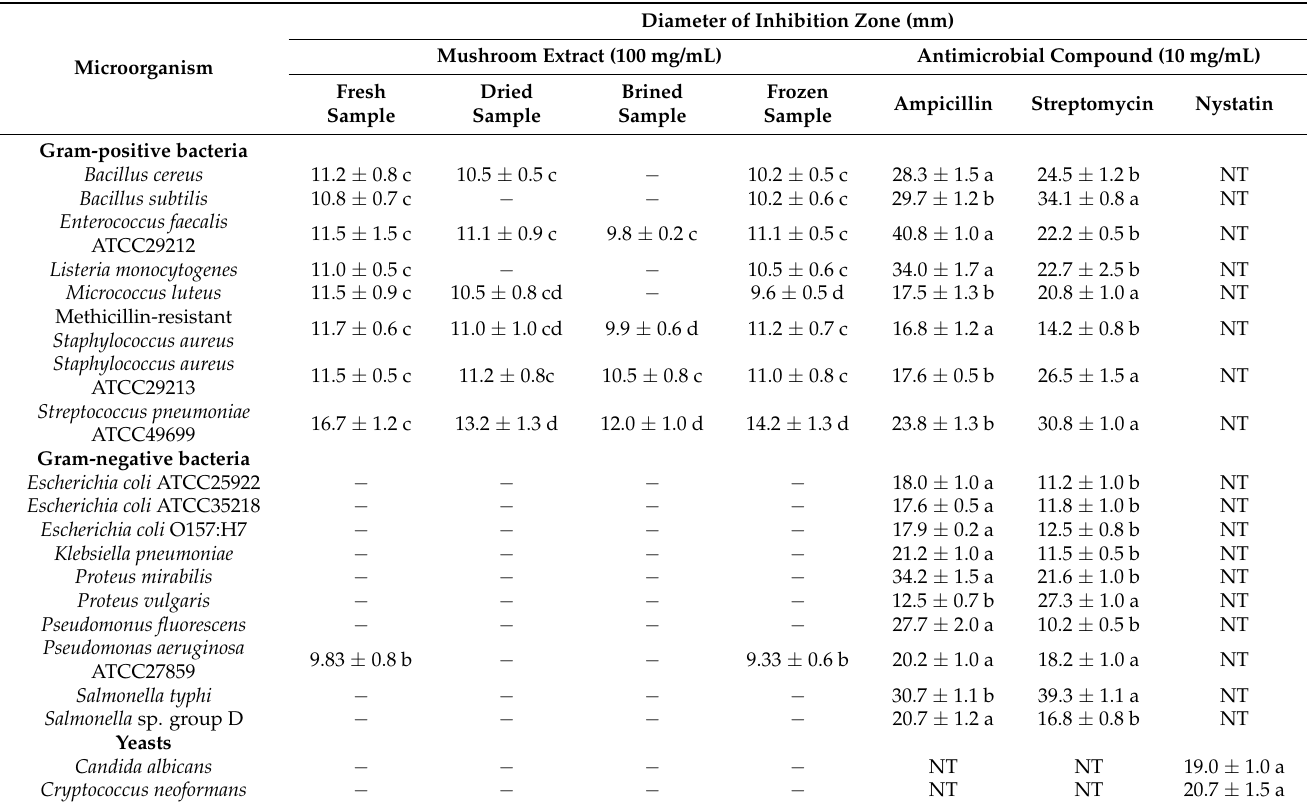
Table 4. Diameter of inhibition zone of the methanolic extracts from different tropical black bolete samples and antimicro- bial